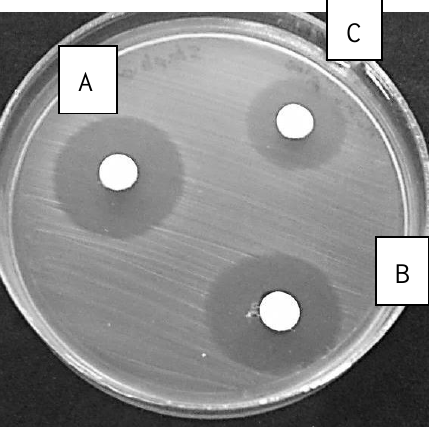
Figure 2. Disk diffusion results for various concentrations of the nanoform of Aloe vera extract on Salmonella 123. A: 0.125 mg/mL; B: 0.062 mg/mL; C: 0.031 mg/mL.